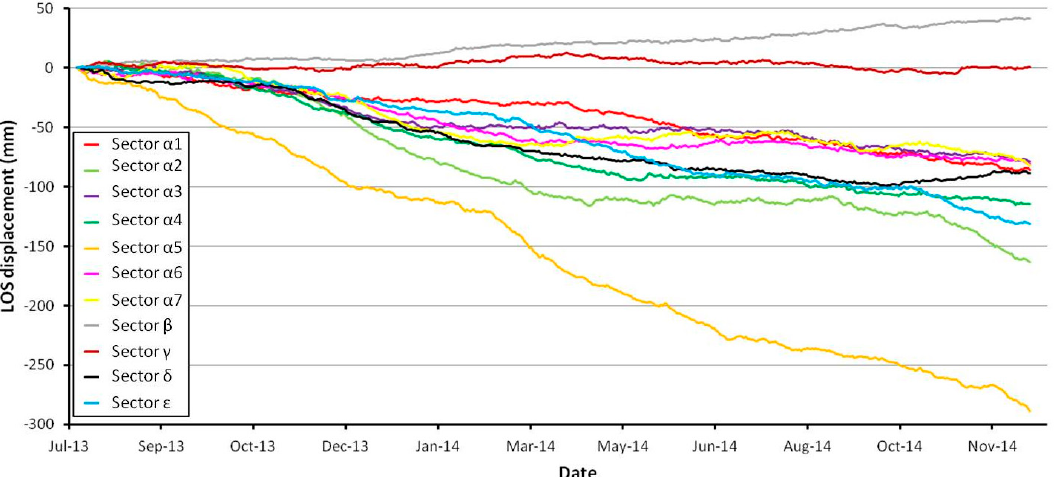
Figure 11 . Time series of deformation for sectors identified in the landslide system. Sector locations are shown in Figure 10.